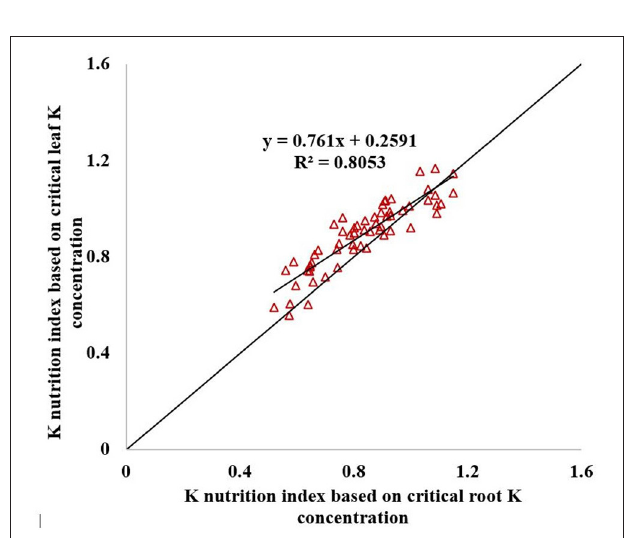
storage root growth to a certain extent (Zhang et al.,